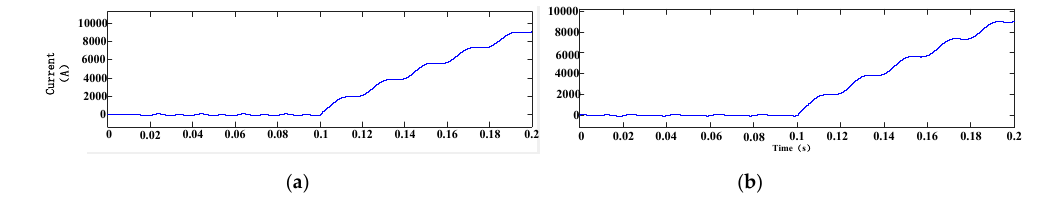
Figure 13. Arm current without fault blocking ( a ) i Ua ( b ) i Ub .